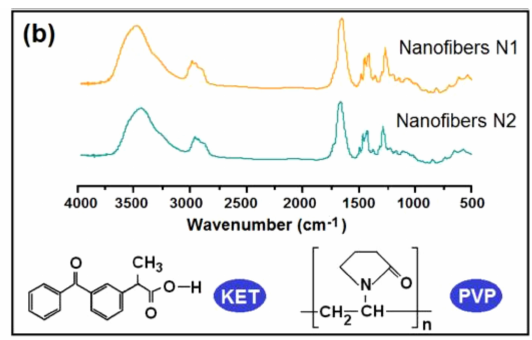
Figure 8. XRD patterns ( a ) and ATR-FTIR spectra ( b ) of nanofibers N1 and N2.